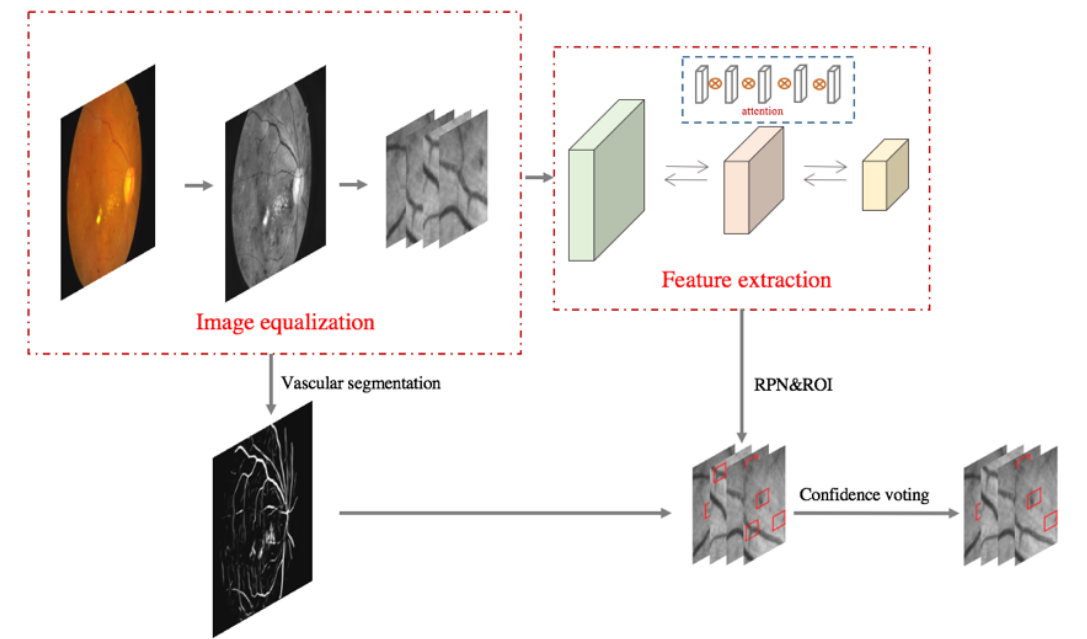
Figure 4. Overview of our algorithm. The details of the image equalization process are shown in Figure 5. The output of feature extraction with the attention mechanism is a fused feature map with 256 channels that is passed to a region proposal network (RPN) along with the region of interest (RoI) for bounding box prediction. Vascular segmentation is conducted on each equalized image to acquire a spatial confidence score for each predicted bounding box; this process is discussed in detail in Section 2.3.7.